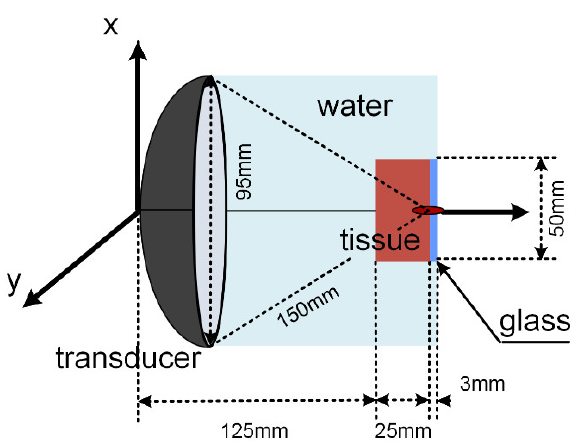
Figure 2. Schematic diagram of the simulation model with infrared